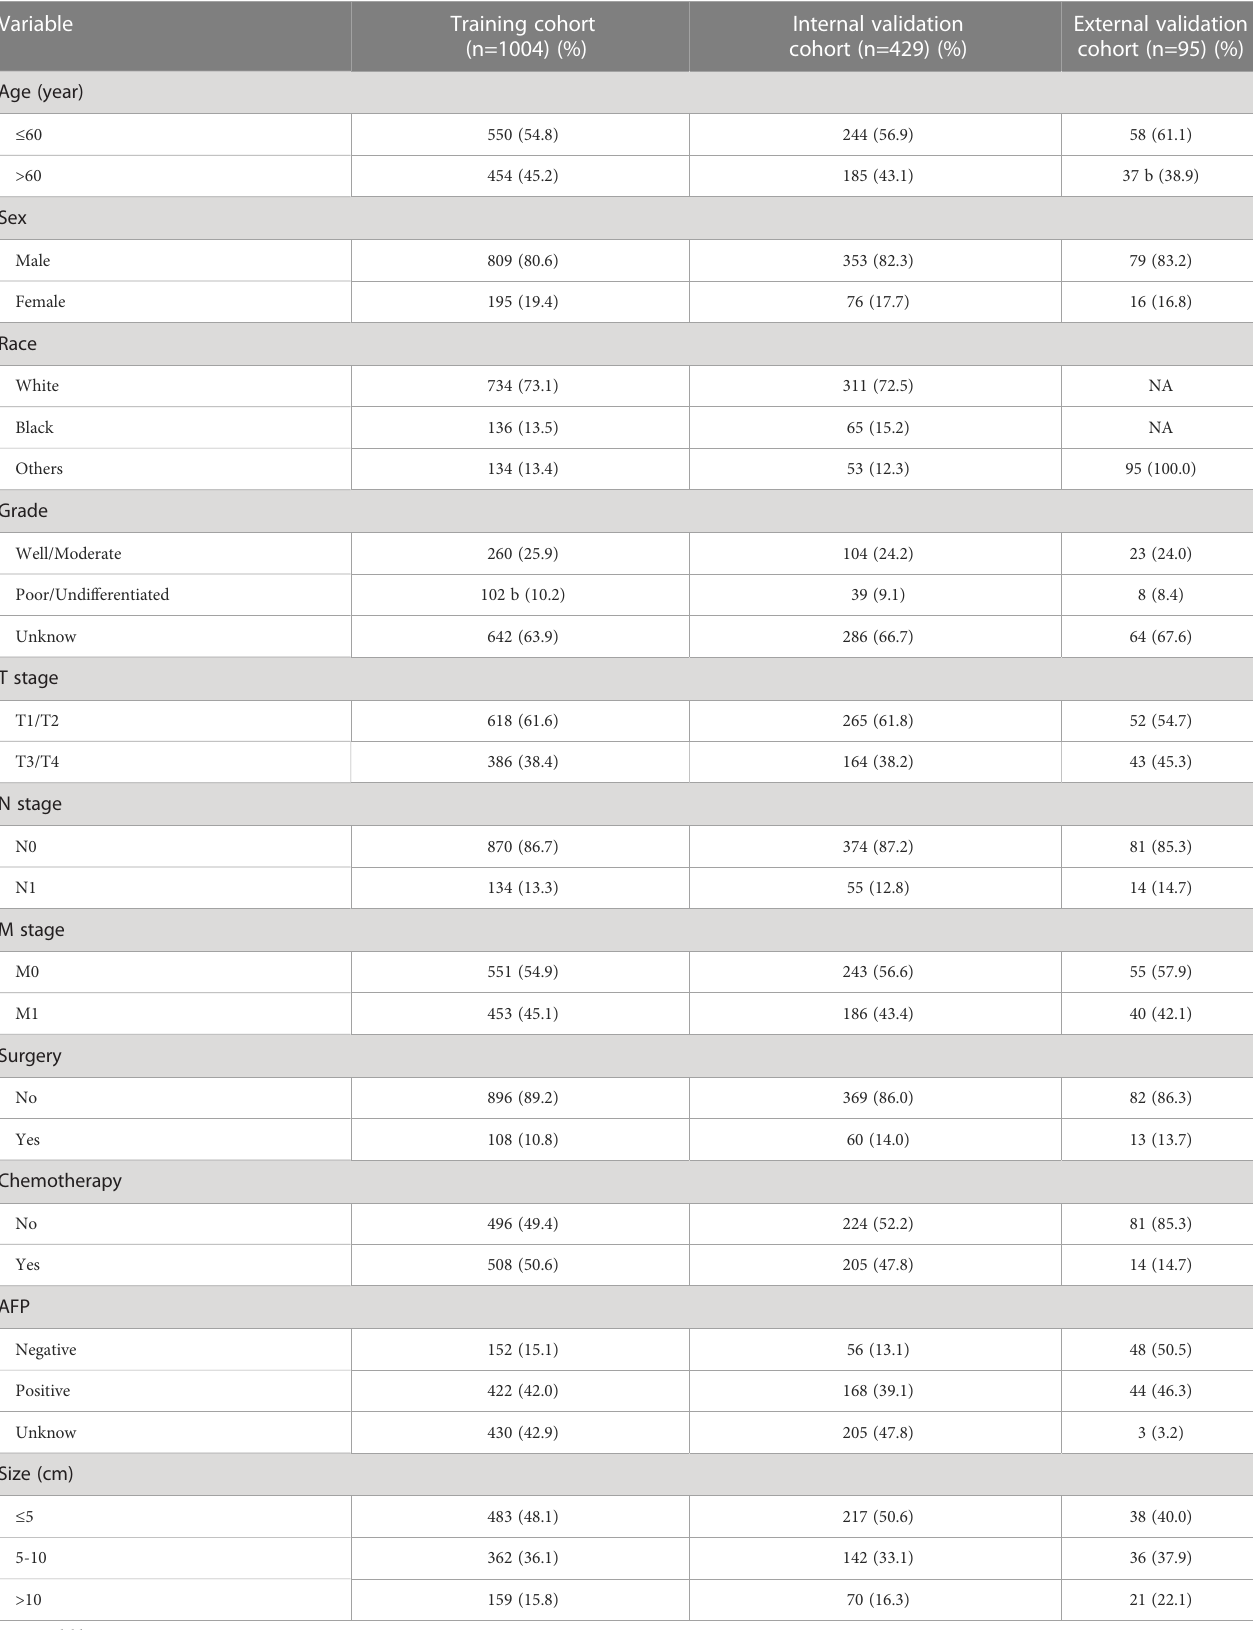
TABLE 1 The baseline clinical characteristics of the HCC in training cohort, internal validation cohort, and external validation cohort.